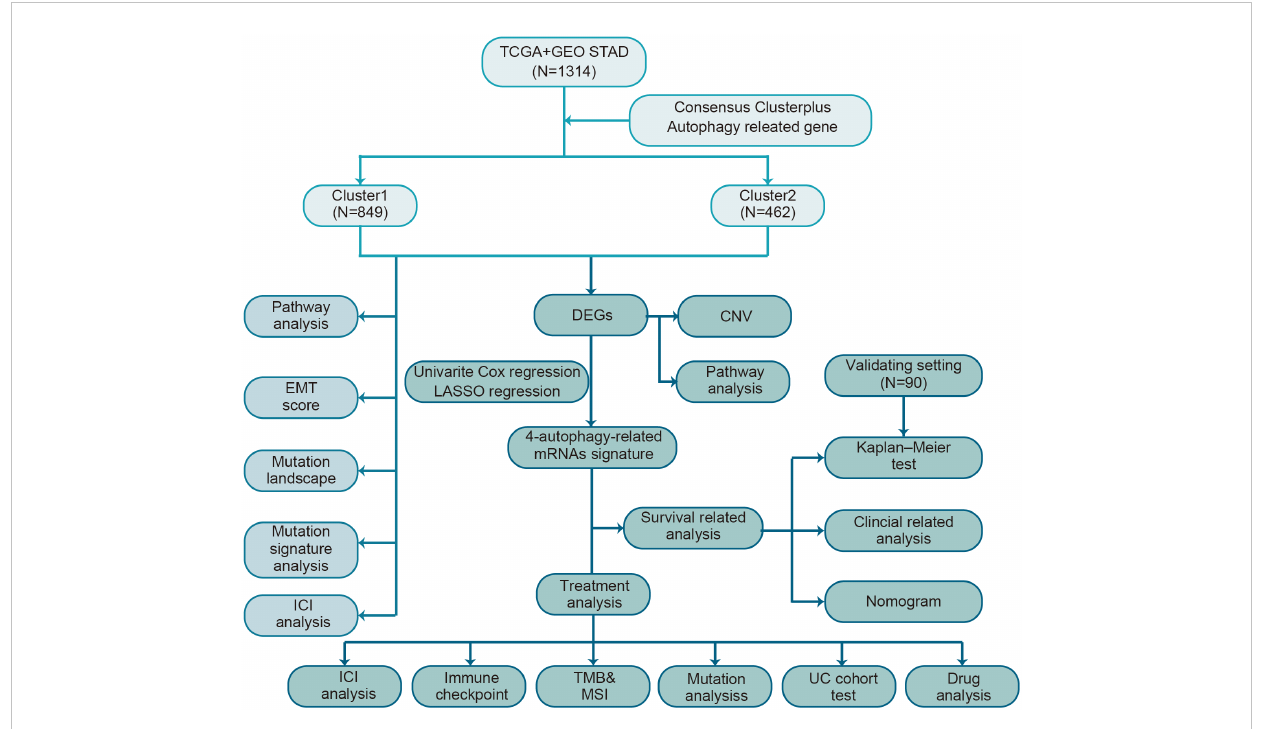
FIGURE 1 The fl ow chart of the study design for autophagy-related subtyping and risk model